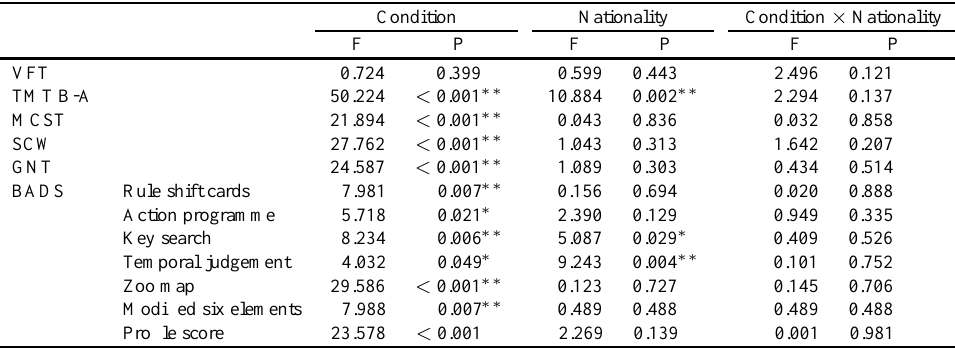
Table 5 ANOVAresults upon neuropsychological results for patients with preserved intelligence, using two between-subject factors: condition (schizophrenic patients versus control subjects) and nationality (Japanese versus